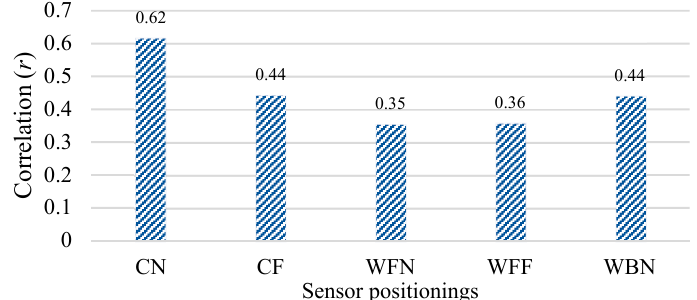
Figure 7. Correlation of CO 2 concentration with occupancy.